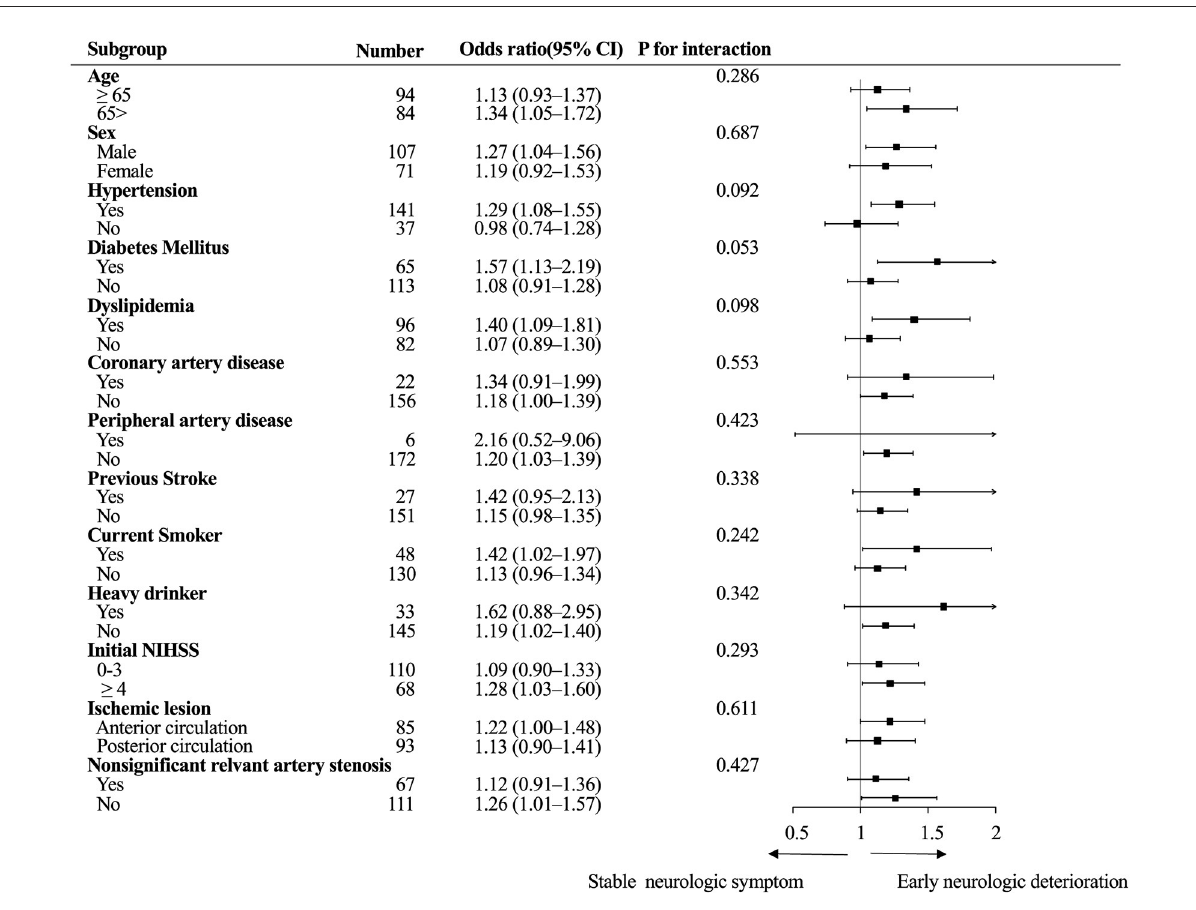
FIGURE2 Subgroup analysis. Logistic regression analysis of the association between diastolic blood viscosity and early neurologic deterioration. CI, confidence interval; NIHSS, National Institute of Health Stroke Scale.